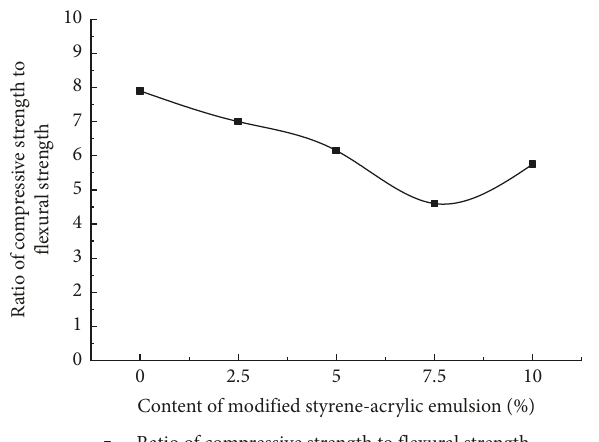
Figure 16: Influence of the modified styrene-acrylic emulsion content on the 28d toughness of the modified cement slurry.